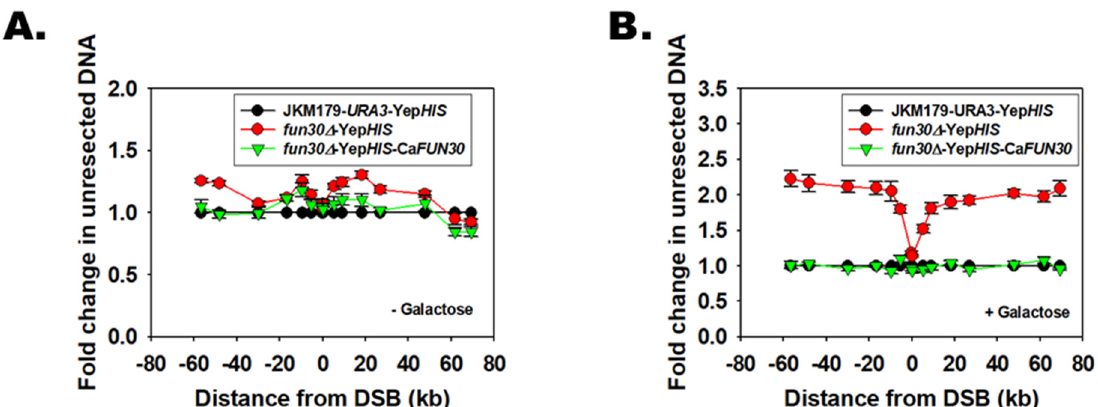
Figure 2. Fun30 protein of C. albicans mediates double-strand break end resection. qPCR was performed on genomic DNA isolated from wild type (JKM179- URA3 -Yep HIS ), fun30 ∆ Yep HIS , and fun30 ∆ overexpressing Ca FUN30 ( fun30 ∆ -Yep HIS -Ca FUN30 ) cells at the indicated distances from